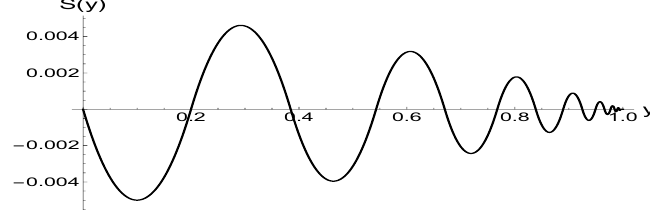
Figure 9. Solutions S k ( y ), k = 2 ; 3 ; (cid:1) (cid:1) (cid:1) for (cid:15) = 0 :